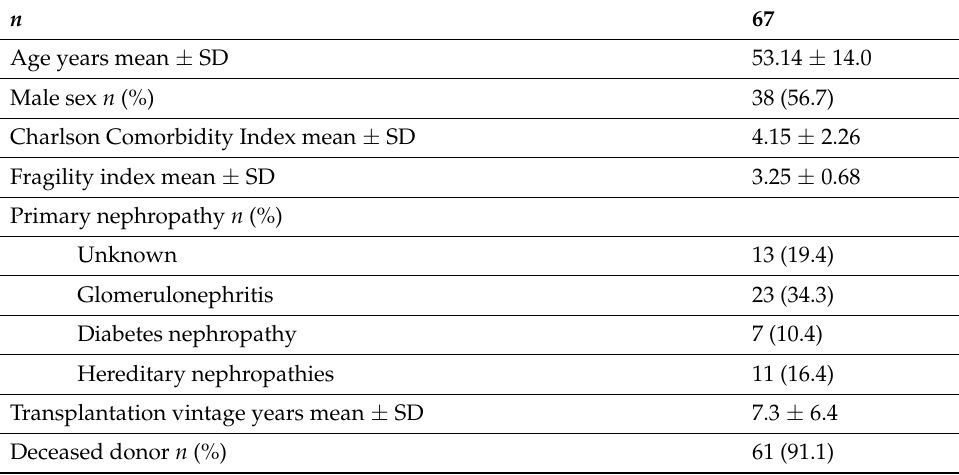
Table 1. Characteristics of study